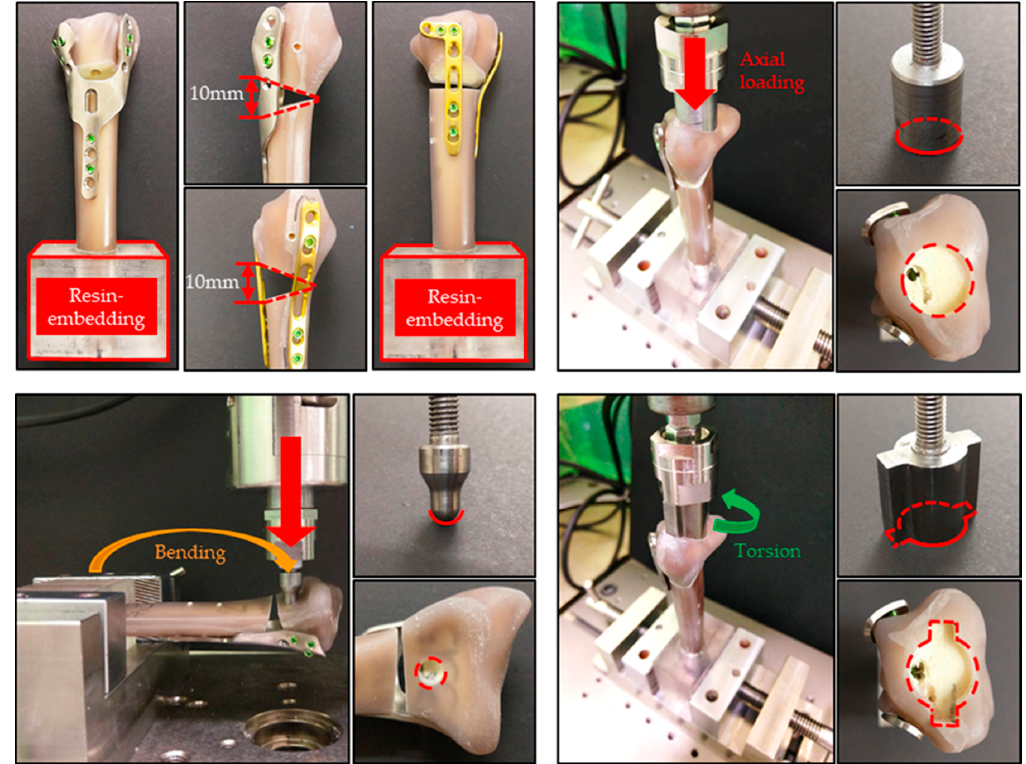
Figure 3. The HDDP and DDP were fixed onto the fractured Sawbone radius (upper-left part). The fractured Sawbone radius was embedded with resin for stable fixation on the vise. Three kinds of loads (axial load, bending, and torsion at the upper-right, lower-left, and lower-right parts, respectively) were applied to the distal radial surface through the corresponding specific loading devices.